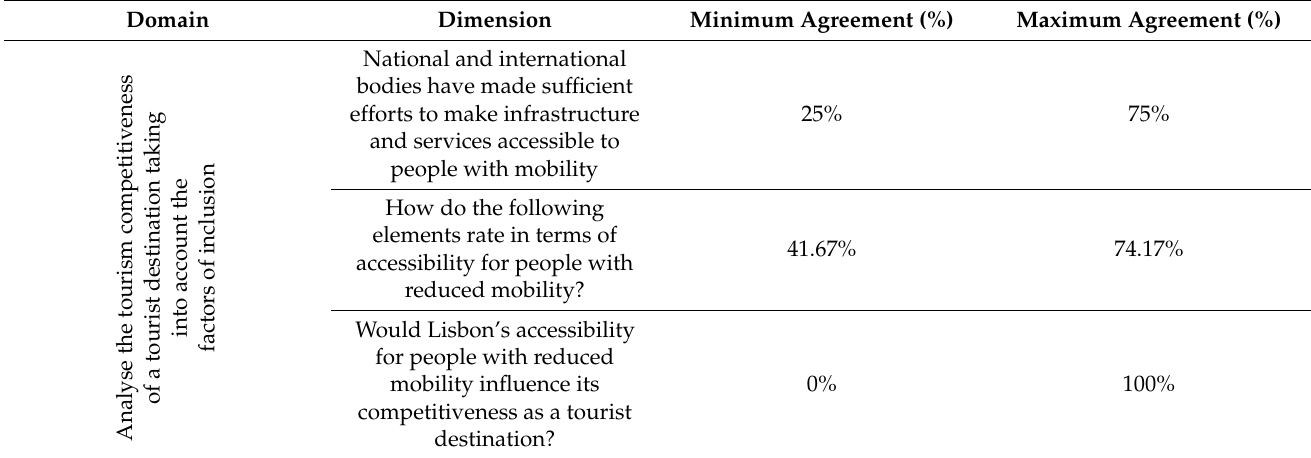
Table 10. Minimum and maximum agreement of the third domain of the interviews. Source: Elaborated by the author.